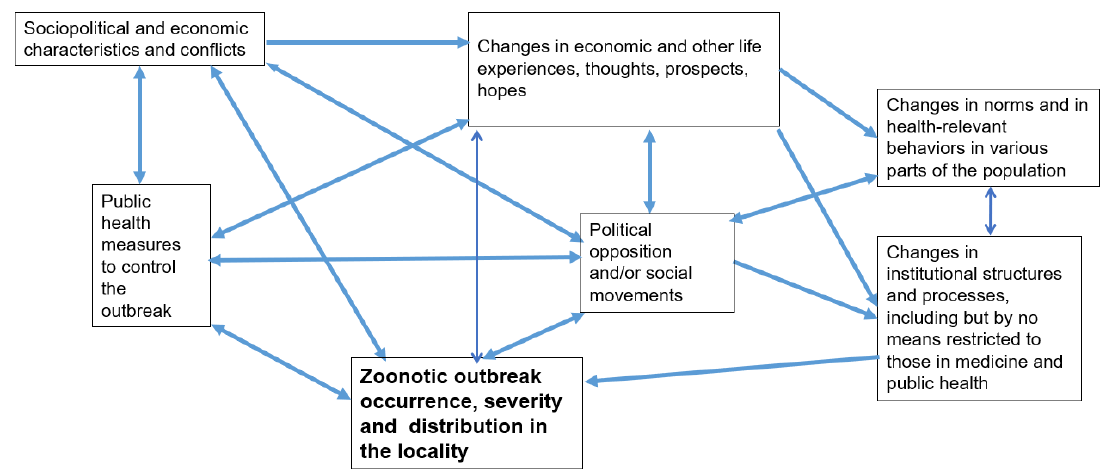
Figure 1. General model of zoonotic outbreaks in a locality in a Big Events framework and what pre-existing social surveillance might be useful. Social surveillance should consider measuring all of the social variables referred to in the Figure. It should be noted that more than one Big Event can take place concurrently. If this occurs, complex interactions may lead to greater peril, depending on the social readiness to meet these other Big